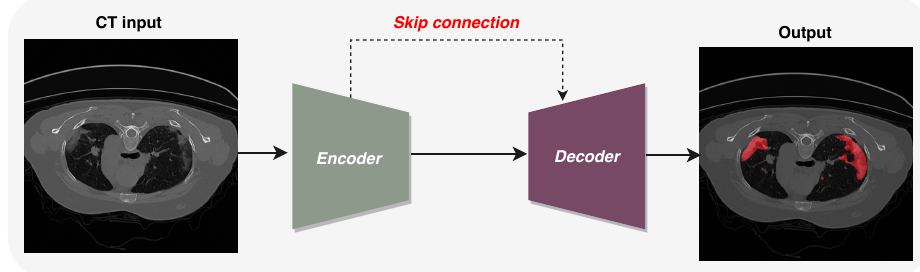
Figure 2. Framework of proposed LungINFseg.